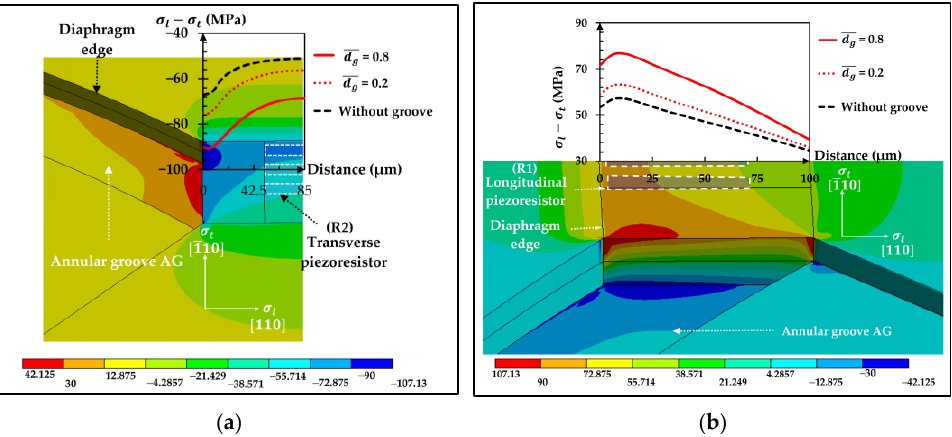
Figure 16. Stress difference distributions at the applied pressure of 5 kPa: ( a ) transverse piezoresistor and ( b ) longitudinal piezoresistor in case of AG- Top ( 𝑑 𝑔 ̅̅̅ = 0.8). (Only one-half of the domain dis- played).